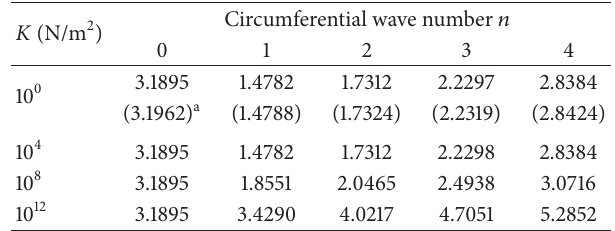
Table 7: Frequency parameters, Ω = 𝜔𝑏(𝜌(1 − V 2 )/𝐸) 1/2 , for C-SS2 annular plates with various cutout ratios.